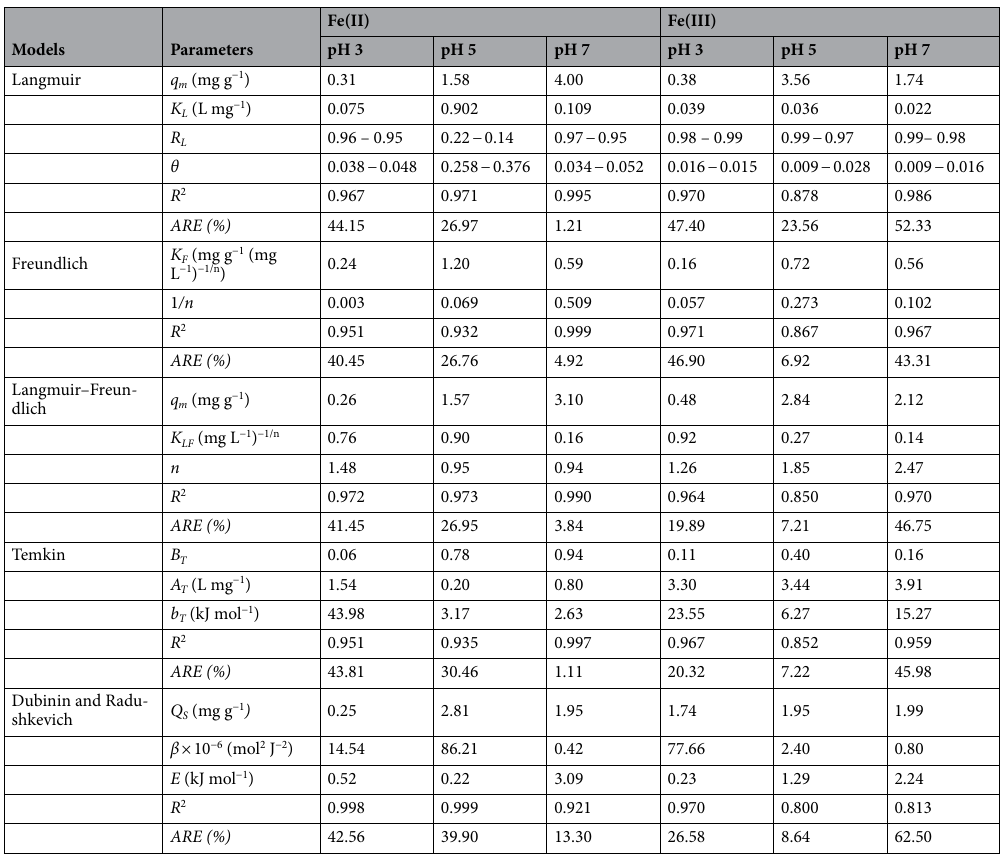
Table 4. Isotherm parameters for Fe(II) and Fe(III) adsorption in a single solution at different initial pH